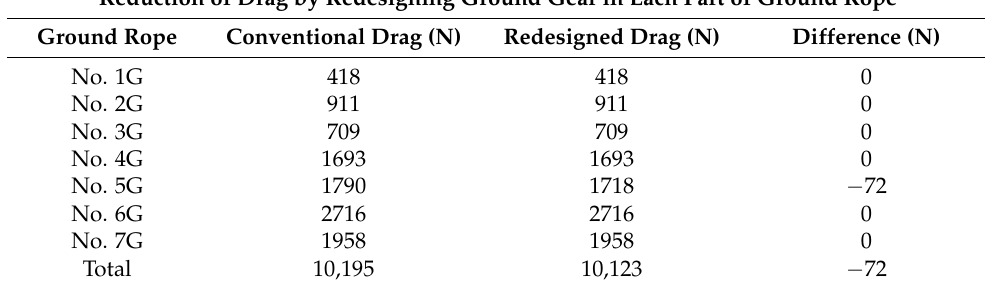
Table 3. The reduction of drag by redesigning ground gear in each part of ground rope. Reduction of Drag by Redesigning Ground Gear in Each Part of Ground Rope Ground Rope Conventional Drag